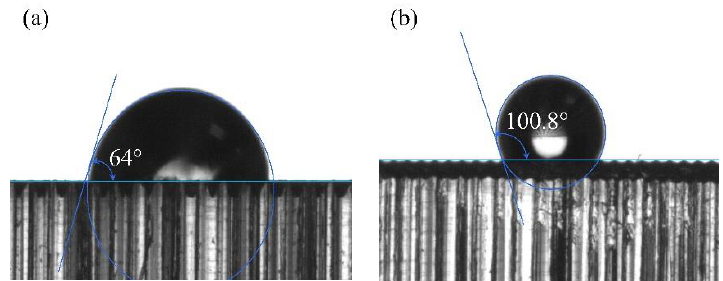
Figure 10. Contact angles of polymethyl methacrylate (PMMA): ( a ) un-machined PMMA and ( b ) sample 1-3.